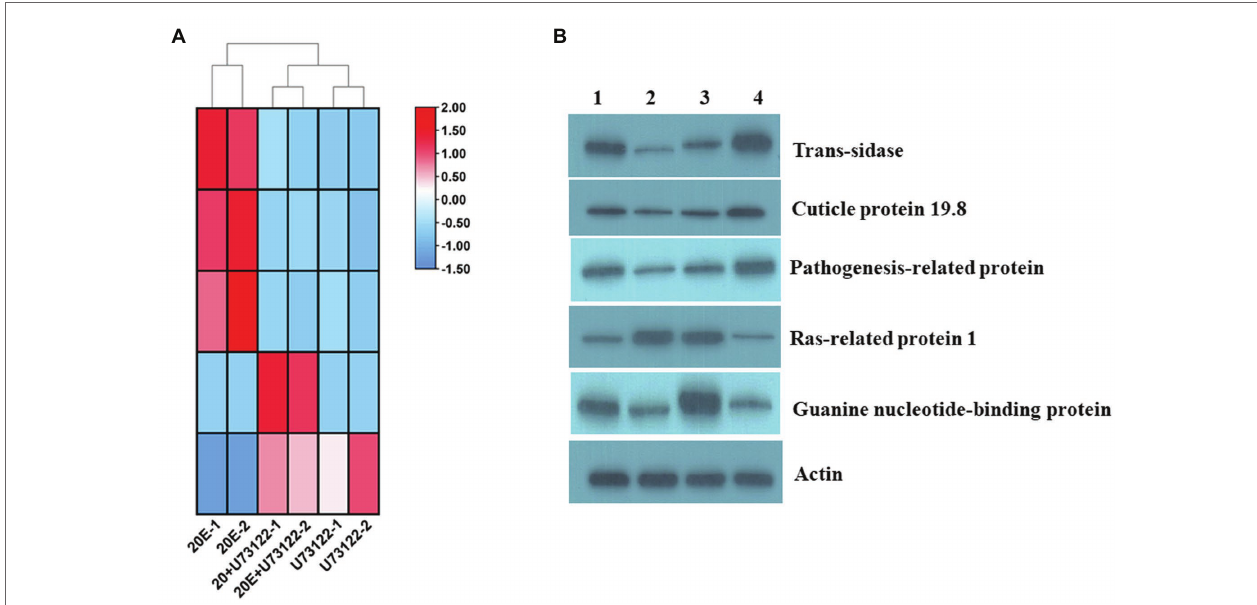
FIGURE 5 | (A) Heat map and (B) Western blotting of Ras-related protein 1 (Rap1), cuticle protein 19.8, guanine nucleotide-binding protein, trans-sialidase and pathogenesis-related protein in different treatment groups of A. lucorum in ITRAQ analysis. Actin was used for normalization. Lanes 1–4 are CK, U73122, 20E + U73122, and 20E,